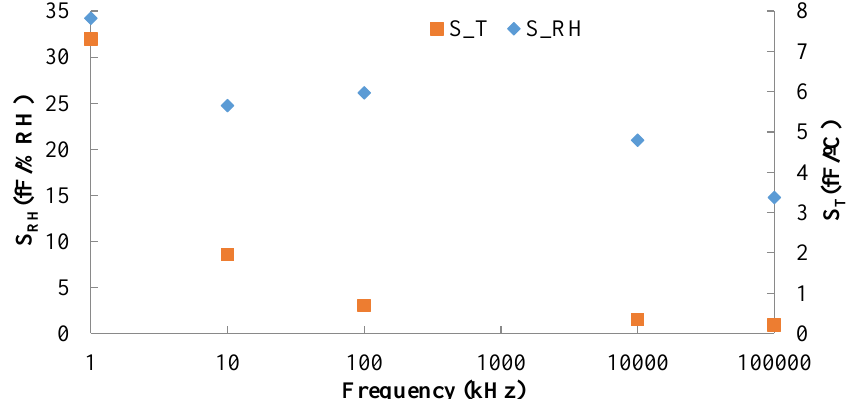
Figure 6. Sensitivity to RH (at 40 °C) and thermal (at 60% RH) sensitivity over frequency.